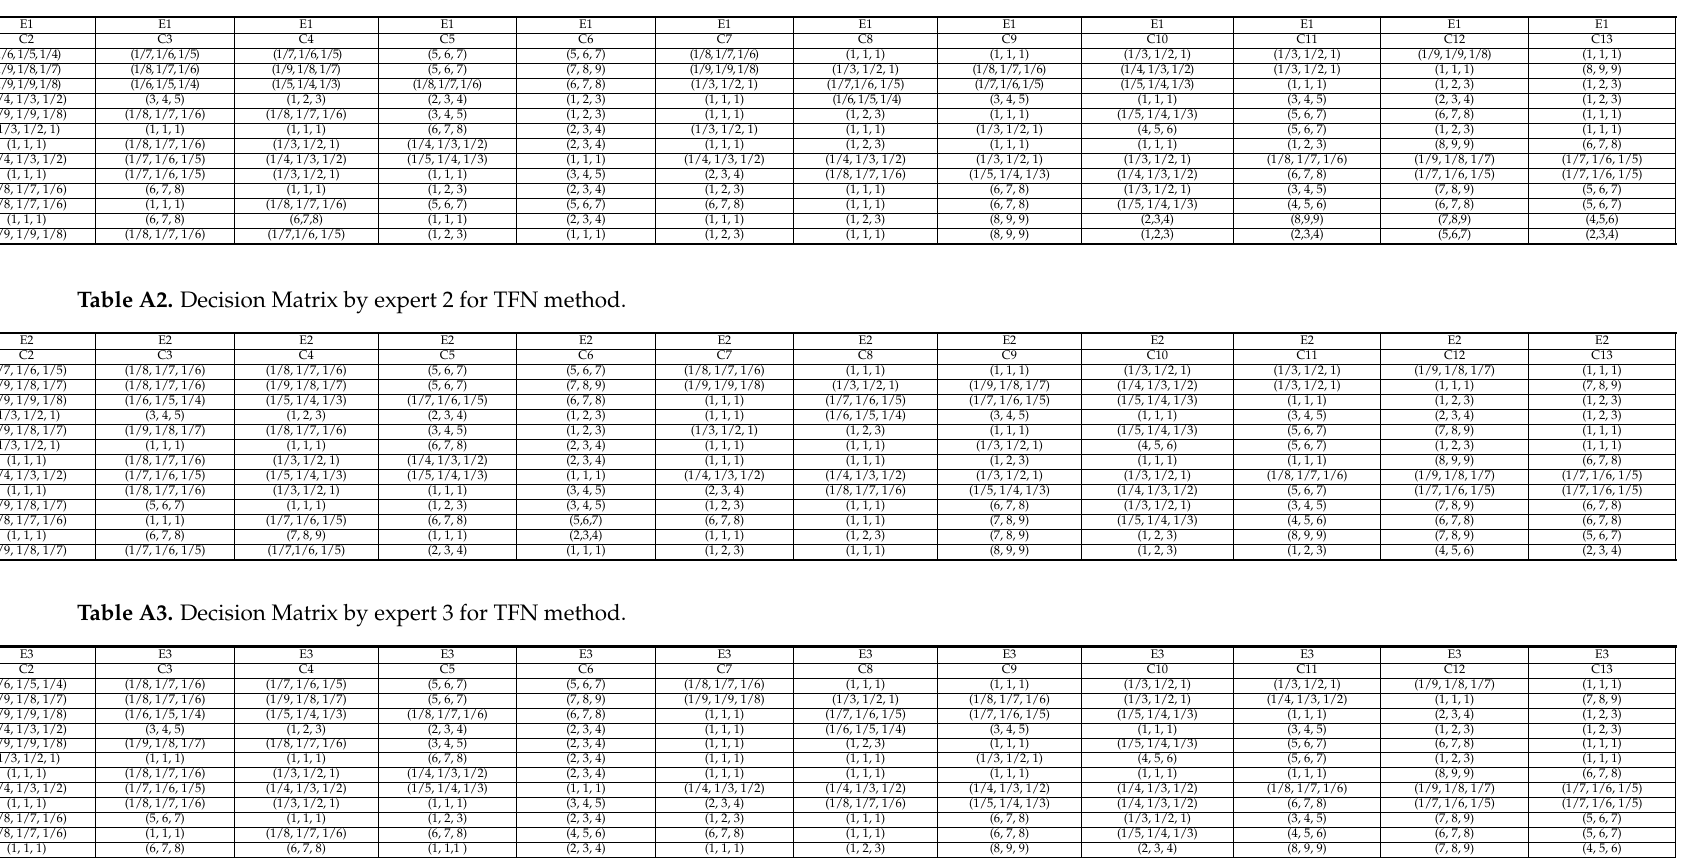
Table A1. Decision Matrix by expert 1 for TFN method.